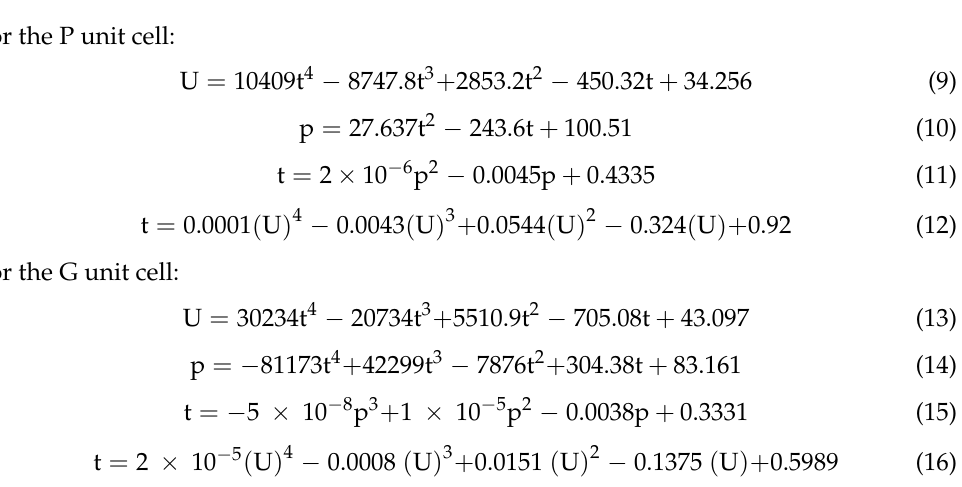
Figure 6. Porosity (p) and surface to volume ratio (S/V P ) versus strut thickness (t) for the respective unit cells ( a ) P ( b ) G.